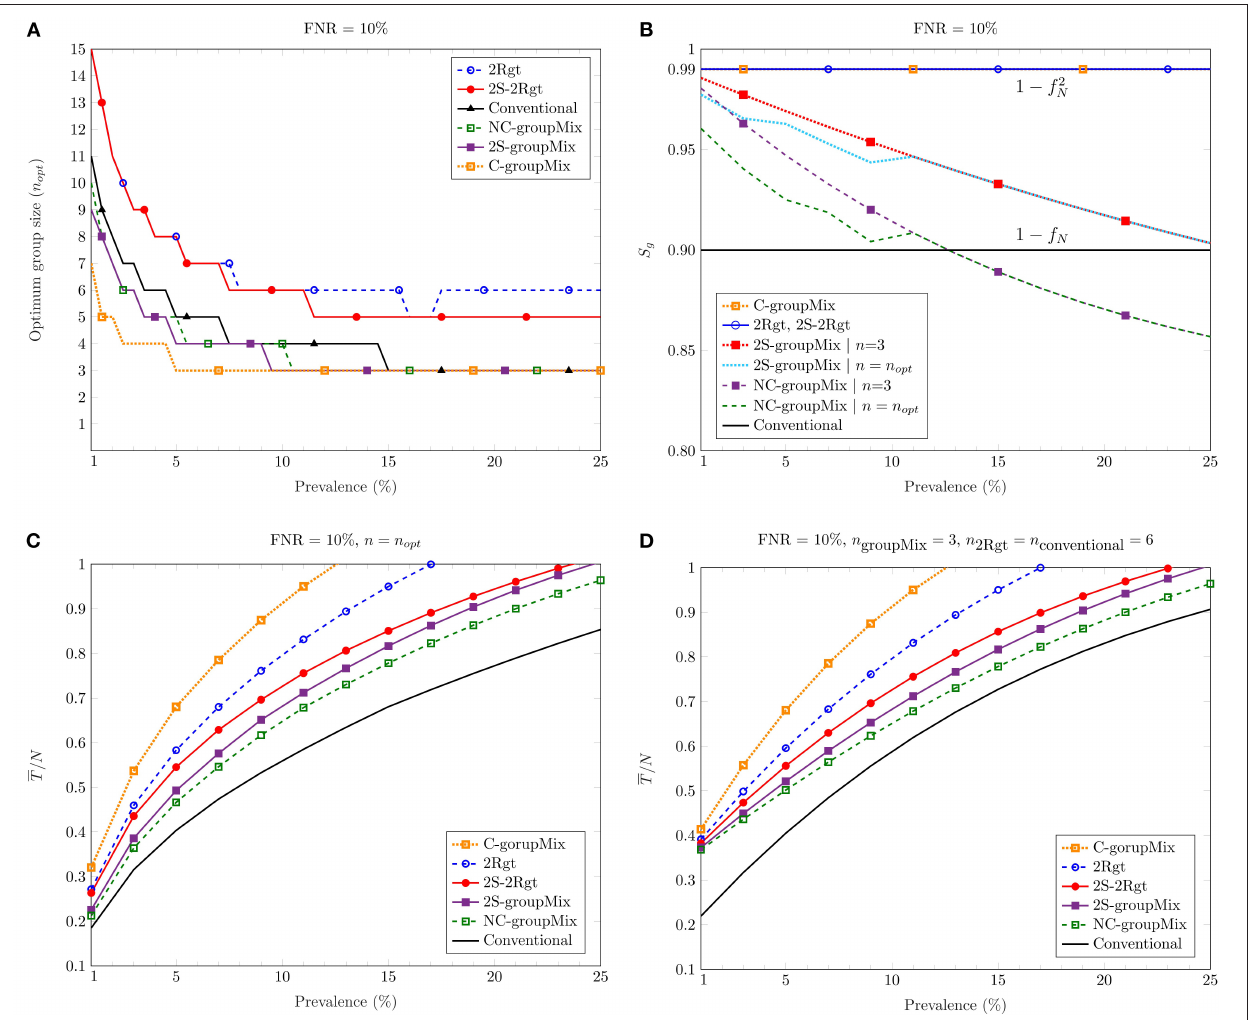
FIGURE 3 | Comparing different methods against the percentage of prevalence: (A) the optimum group size n opt to minimize the average number of tests; (B) the group-level sensitivity S g of the methods; (C) the average number of tests per sample for n = n opt ; (D) the average number of tests per sample for the group (or the mixed group in the groupMix method) size of